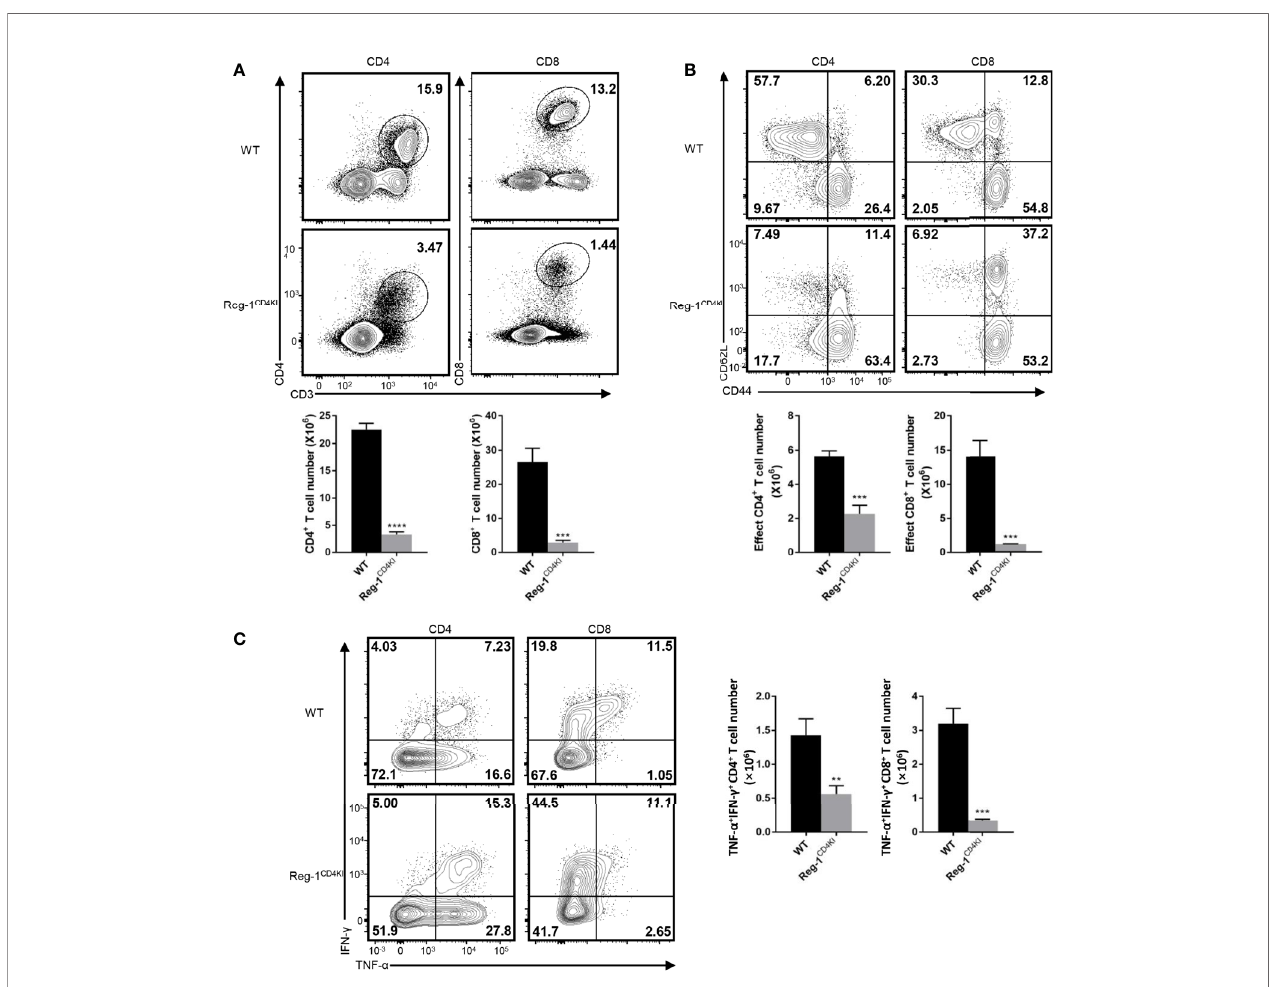
FIGURE 4 | Reduced T effector cells in Reg-1 CD4KI recipient after skin transplantation. (A) The percentage and number of CD4 + or CD8 + T cells in spleen based on the expression of CD3, CD4 and CD8. (B) The percentage and number of effect T cells in CD4 + or CD8 + splenocytes, based on the expression of CD44 and CD62L. (C) The percentage and number of IFN- g + TNF- a hi T cells in CD4 + or CD8 + splenocytes. Data are mean ± SD (n=3) from one experiment, representative of three independent experiments. ** P < 0.01; *** P < 0.001; **** P < 0.0001 (unpaired two-tailed Student ’ s t